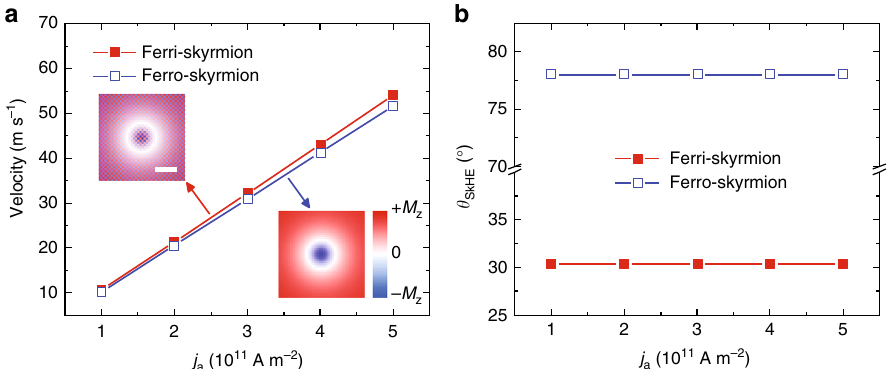
Fig. 3 Comparison between the current-driven dynamics of ferrimagnetic and ferromagnetic skyrmions of the same net saturation magnetization. a The ferrimagnetic and ferromagnetic skyrmion velocities as a function of the driving current density. Insets show the close-up top views of the ferrimagnetic skyrmions in a square fi lm with periodic boundary conditions in both x and y directions. The lattice constant is set as 5 Å. b The ferrimagnetic and ferromagnetic skyrmion Hall angle as a function of the driving current density. The net saturation magnetization was set to be M S = 2×10 5 A m − 1 for both cases. Scale bar, 5